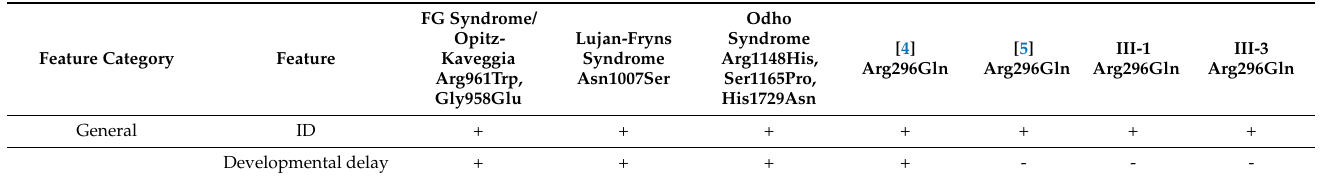
Figure 1. Pedigree and photographs. ( a ) Pedigree of the two probands. Filled circles represent carrier females, unfilled squares represent unaffected males, filled squares represent affected males. Arrow indicates the probands. ( b ) Facial dysmorphisms of the two affected subjects (III-1 on the left, III-3 on the right) with facial features consistent with X-linked Ohdo syndrome: thin and arched eyebrows, blepharophimosis, ptosis, round face with a characteristic nose and a narrow mouth. Table 1. Comparison of clinical findings among the three well-known MED12-related syndromes (FG, Lujan-Fryns and Odho), the probands with Arg296Gln variation previously described [4,5] and the two probands with Arg296Gln mutation described in the present